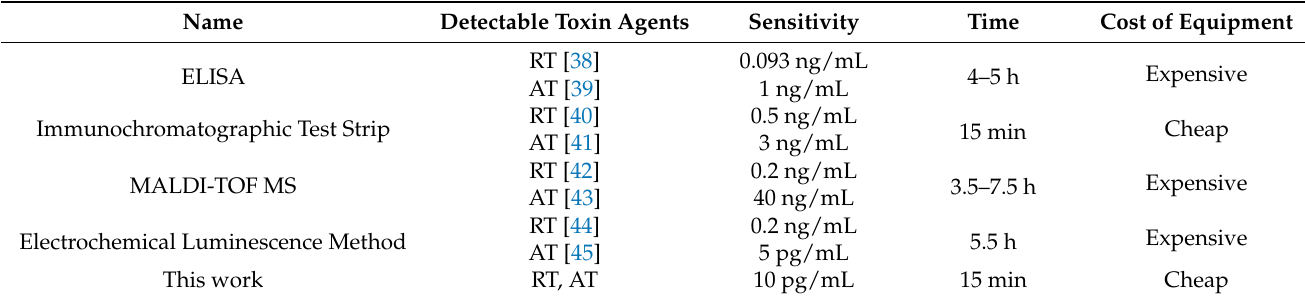
Table 2. Comparative analysis of several different detection methods for AT and RT.